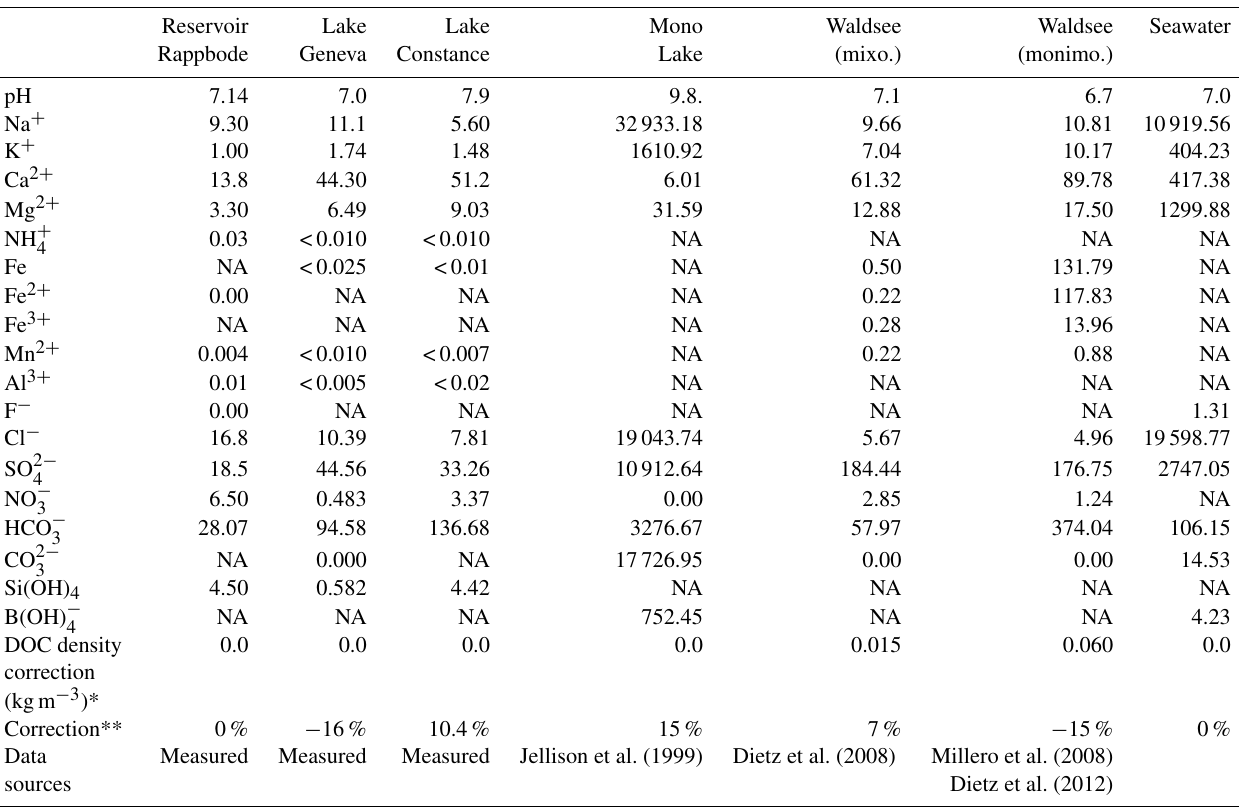
Table 1. Original chemical composition of the water in different test cases presented in Sect. 3. All values except pH are presented in mgL − 1 (NA – not